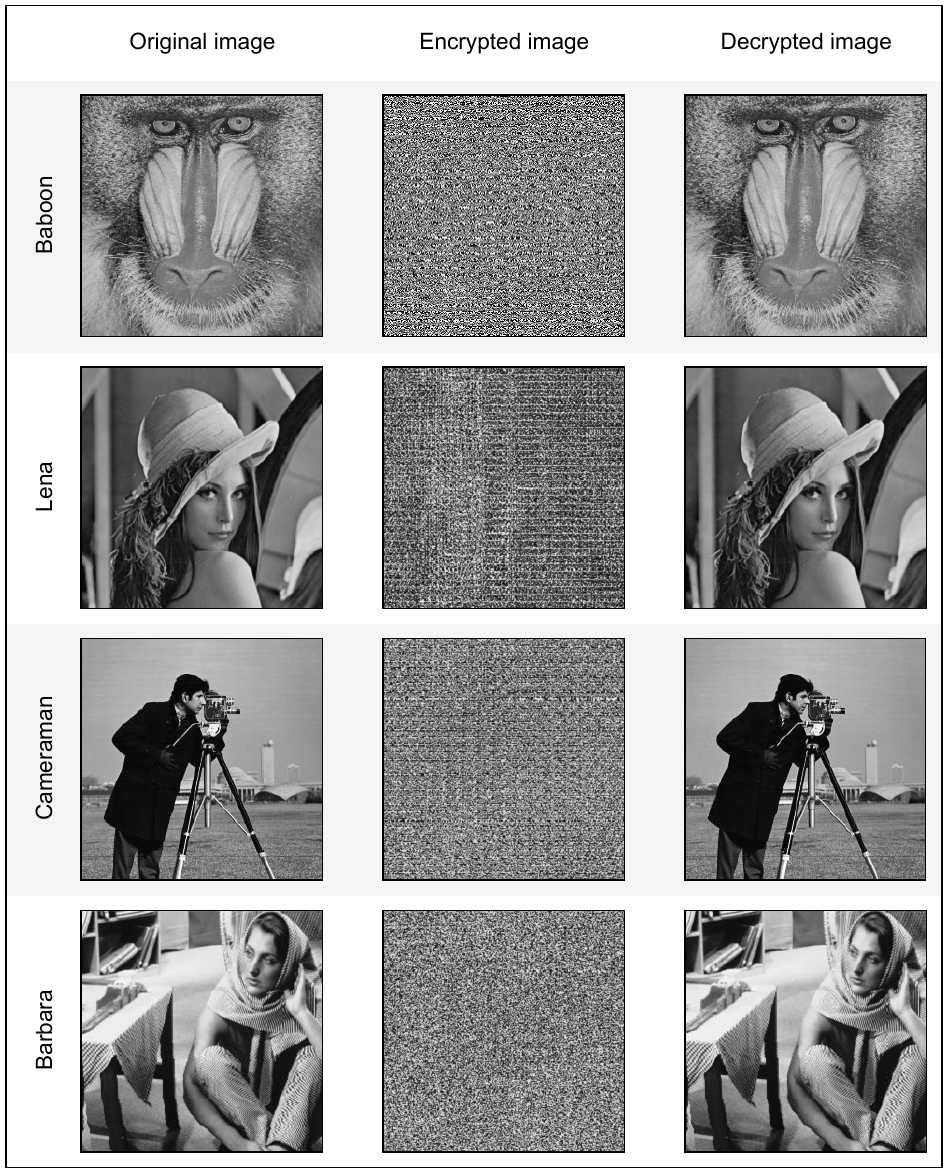
Figure 7. Results of encrypted and decrypted test